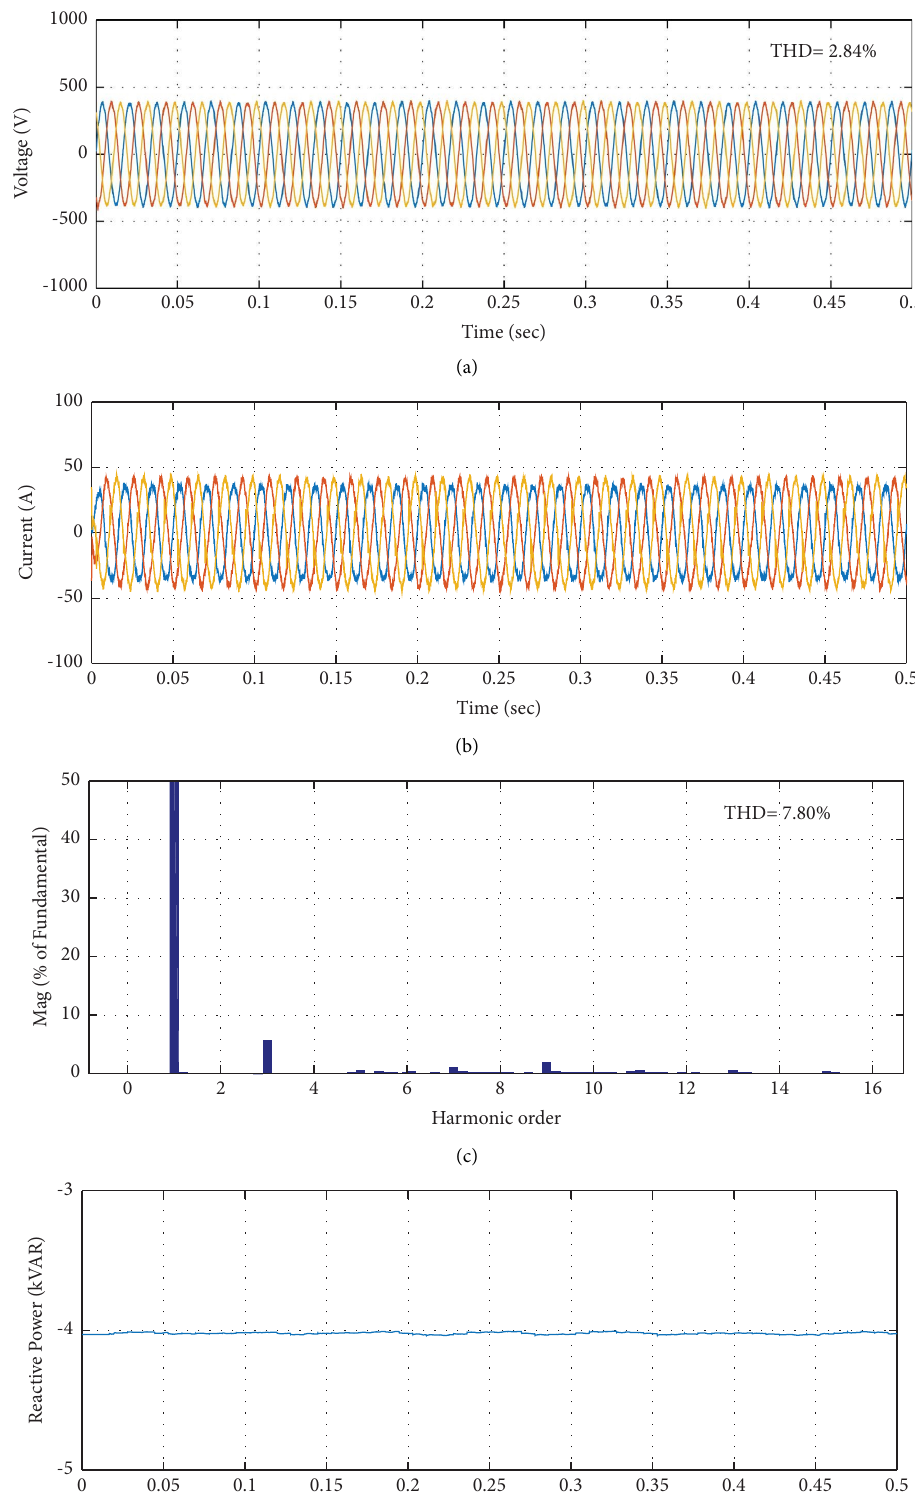
Figure 13: Performance during light nonlinear loading with SC-integrated APFs. (a) Load voltage waveform, (b) load current waveform, (c) FFT analysis of load current, and (d) reactive power of the